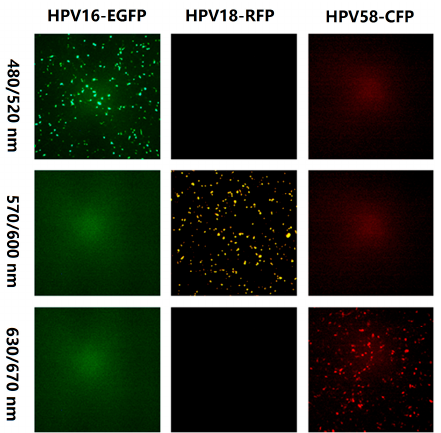
Figure 1. Fluorescence of three fluorescent proteins under different excitation and emission filters. The excitation and emission filter wavelengths for row 1 were 480 nm and 520 nm, respectively. For row 2, the excitation and emission filter wavelengths were 570 nm and 600 nm, respectively. For row 3, the excitation and emission filter wavelengths were 630 nm and 670 nm, respectively.